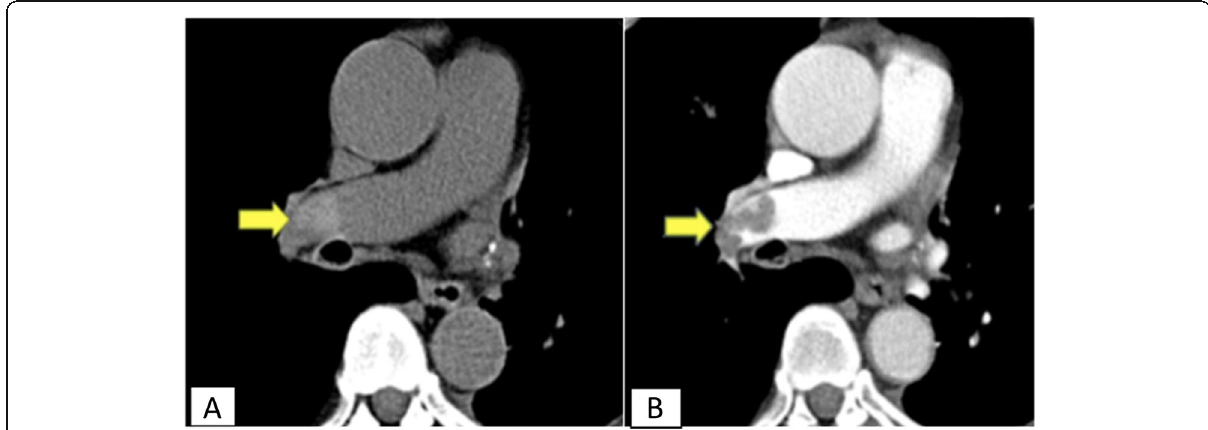
Fig. 1 a Axial non contrast CT image. b Axial CTPA image shows a case of acute pulmonary embolism with hyperdense thrombus seen at right main pulmonary artery (arrows in a ) with corresponding filling defect at right main pulmonary artery (arrows in b